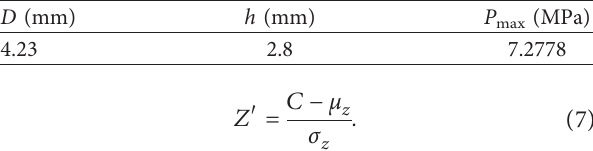
Figure 5: Response surface and residuals of the training points. Table 3: Optimal design variables and optimal